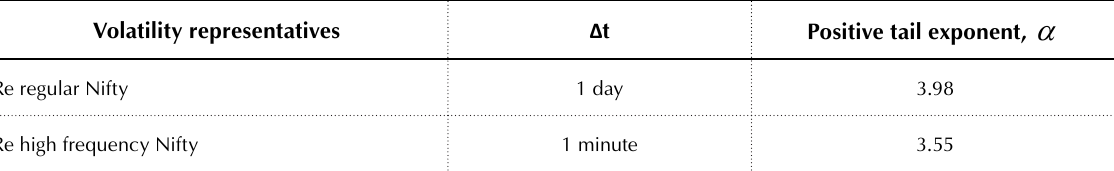
Table 1. Comparison of the power law exponent α of the cumulative distribution function for various index based volatility proxy (financial Reynolds number) Volatility representatives ∆ t Re regular